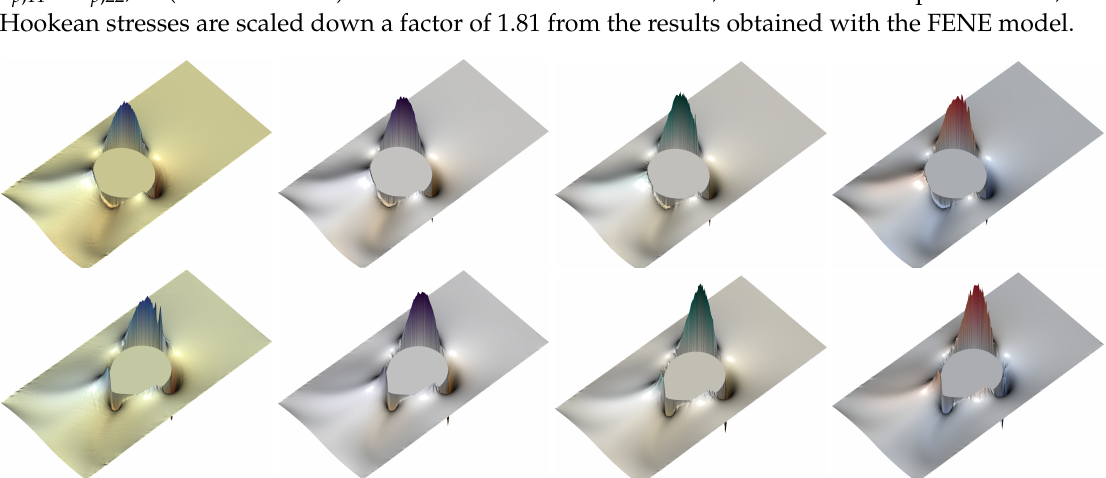
Figure 9. Representation of the shear component of the polymer stress tensor, τ p ,12 , for the FENE model ( b = 50) with c = 5, De = 3, at dimensionless instants of time t = 2 and t = 3, for variable types of CSRBF. From left to right: ϕ 3,0 , ϕ 3,1 , ϕ 3,2 , ϕ 3,3 . Top row: t = 2; bottom row: t = 3.